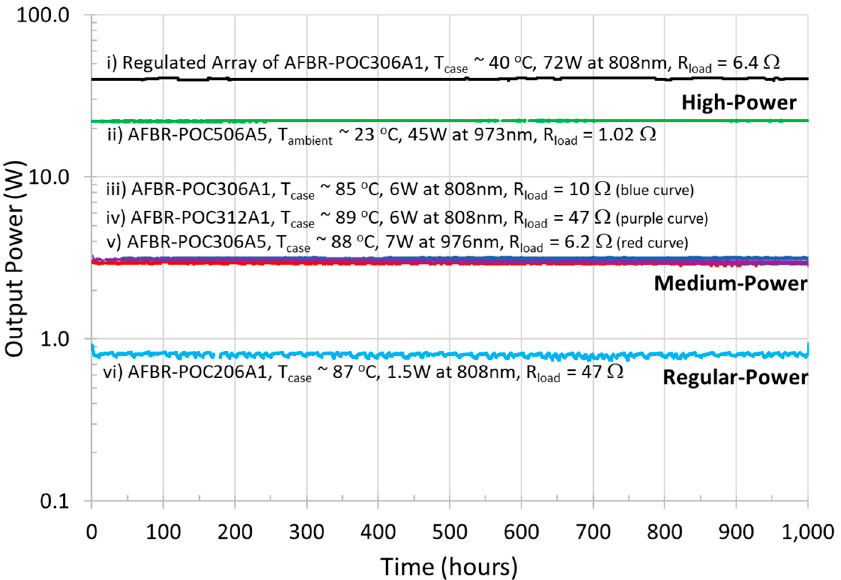
Figure 4. Stability measurement, in DC steady-state operation, of Broadcom’s photovoltaic OPCs covering various power, voltage, and spectral range options. The test conditions are indicated on the plot, where T case is the measured case temperature and R load is the fixed output resistor used. The high-power AFBR-POC506A5 OPCs have an area of 1 cm 2 , giving an average optical input intensity of 45 W/cm 2 at 45 W.